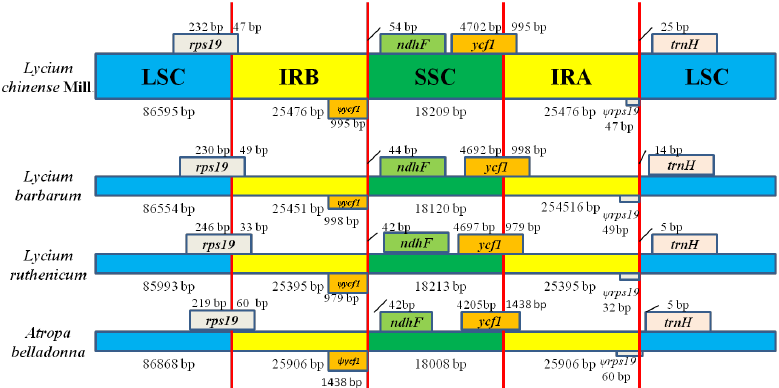
Figure 4. Comparison of the borders of large single copy regions (LSC), small single copy (LSC) and inverted repeat (IR) regions among four chloroplast genomes (not to scale). Number above the gene features means the distance between the ends of genes and the borders sites. The IRb / SSC border extended into the ycf1 genes to create various lengths of ycf1 pseudogenes among four chloroplast genomes, while the IRa / LSC border extended into the rps19 genes to create various lengths of rps19